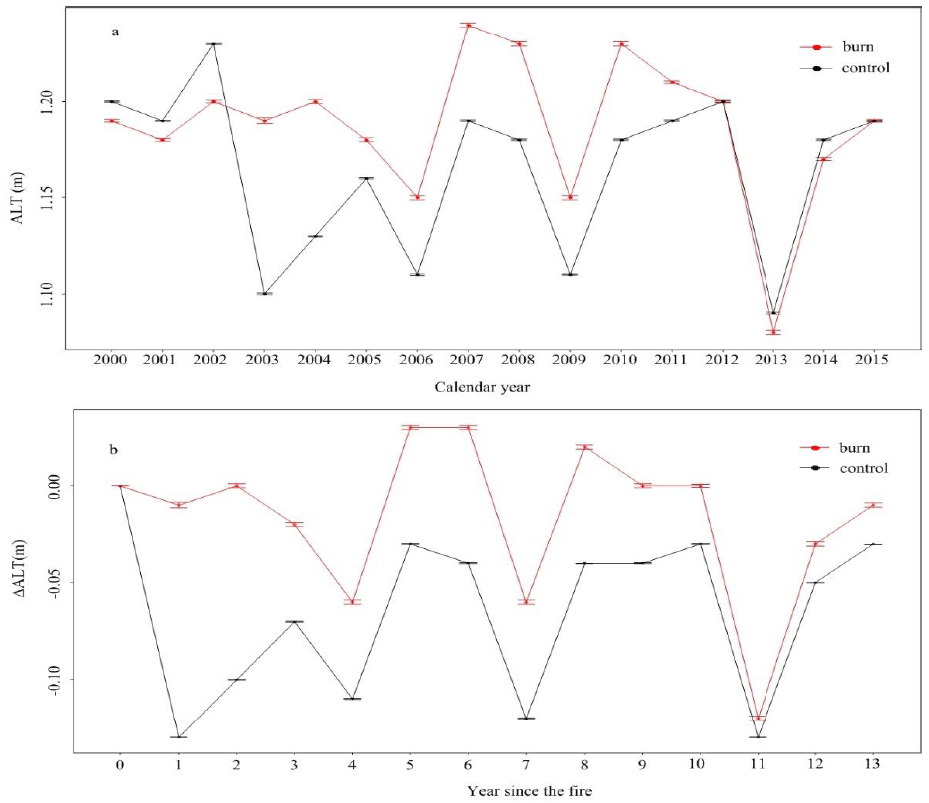
Figure 5. Interannual variations in ( a ) active layer thickness (ALT) and ( b ) ∆ALT (ALT i – ALT 2002 , where i varies from 2003 to 2015) in burned and control areas in Genhe County. Error bar means standard error.